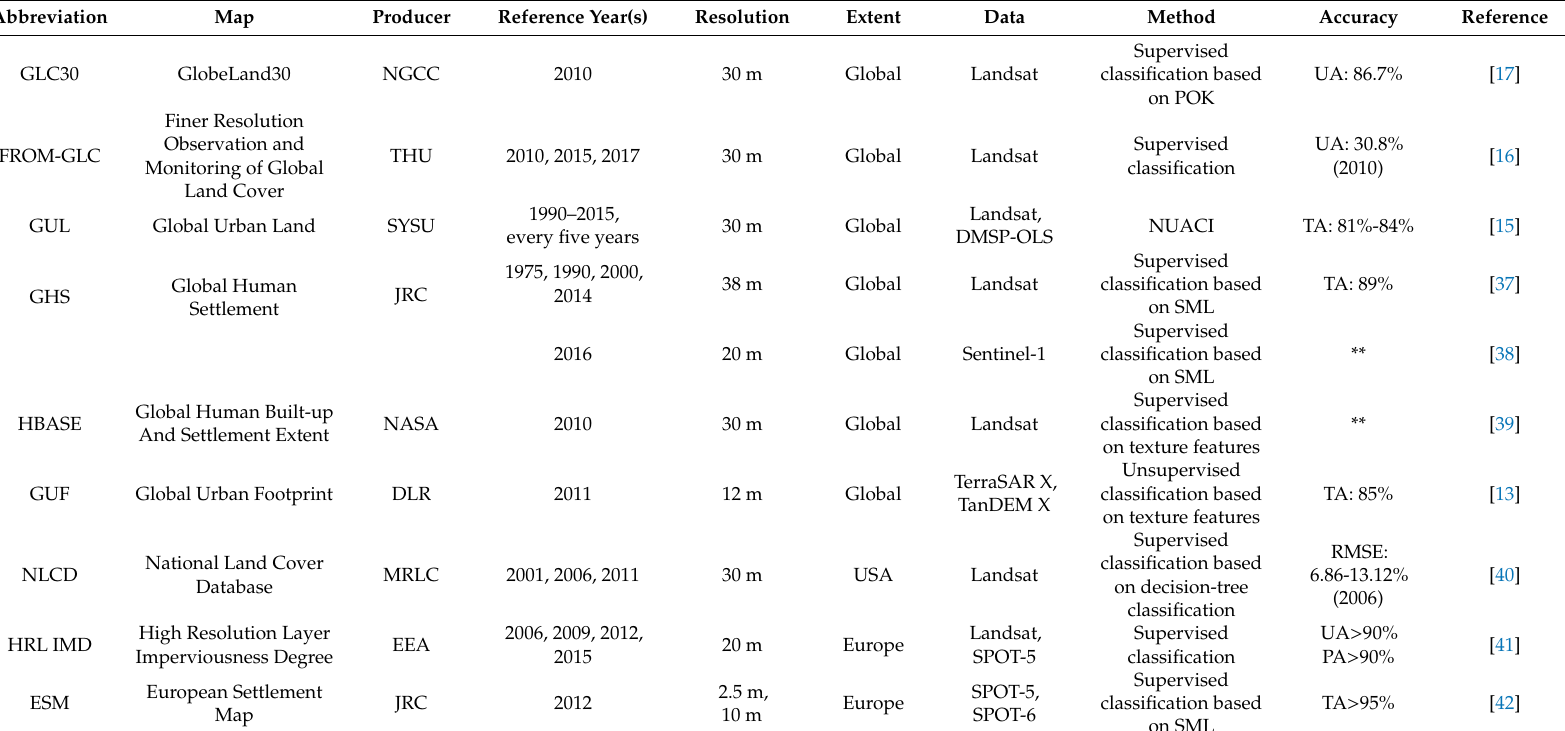
Table 1. Global and regional high-resolution built-up area